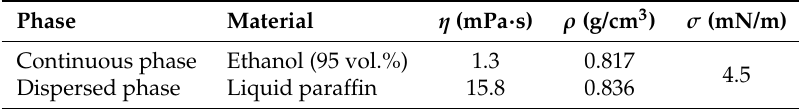
Table 1. The physical properties of the two-phase flow (room temperature 22 ◦